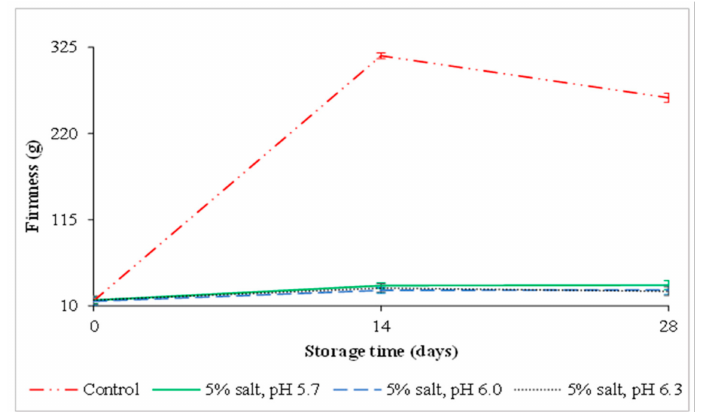
Figure 13. The effect of treatment on the firmness of frozen-thawed liquid egg yolk. Data are presented with mean ± standard deviation.